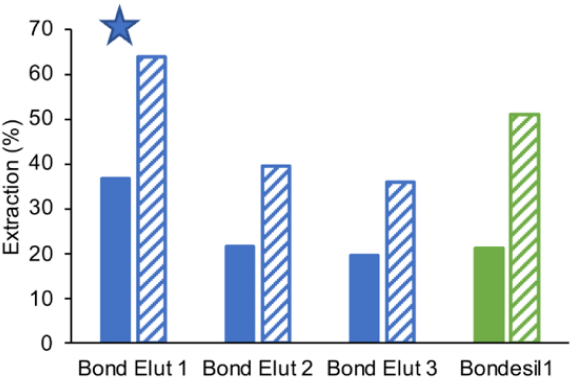
Figure 2. Extraction efficiency of Bond Elut PPL ( n = 3) and the Bondesil PPL after passage of 100 mg FA (2 L of 50 mg/L FA solution) per 500 mg sorbents. One Bond Elut PPL cartridge was characterized with higher-than-average results—it is marked with a star. The solid columns refer to the extraction efficiency values normalized to the total amount of the discharged FA (100 mg). The striped columns refer to the extraction efficiency values normalized to the real loading of sorbents.